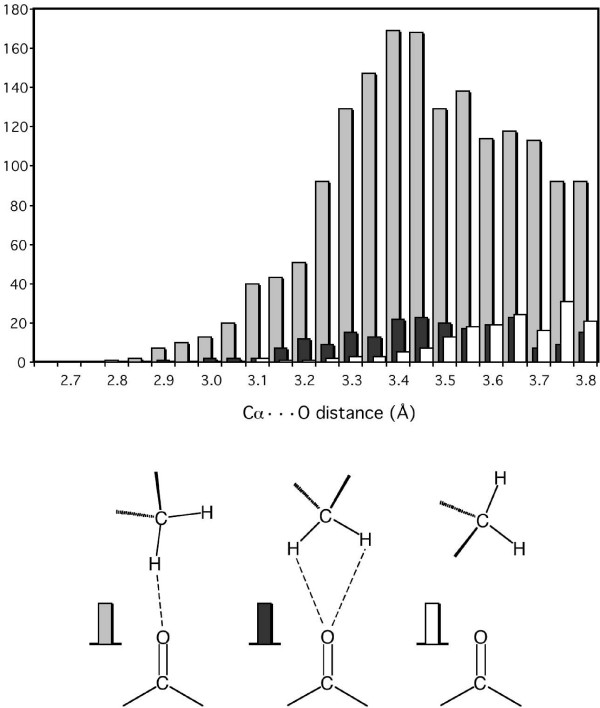
Distribution of Cα···O distances in the Cambridge Structural Database structures (July 2003 release), containing the motif depicted in Figure 2. Three cases are considered: single Cα-H···O hydrogen bond (light grey), bifurcated hydrogen bond (dark grey), and no hydrogen bond (white). The single hydrogen bonded case clearly dominates with 1688 hits overall, for 218 of the bifurcated case and 166 hits for the no hydrogen bond case. The maximum in the single hydrogen bond distribution around 3.4 Å suggests that value as the Cα···O hydrogen bonding distance, although a significantly large number of interactions can be still classified as hydrogen bonds at the longer Cα···O distances.